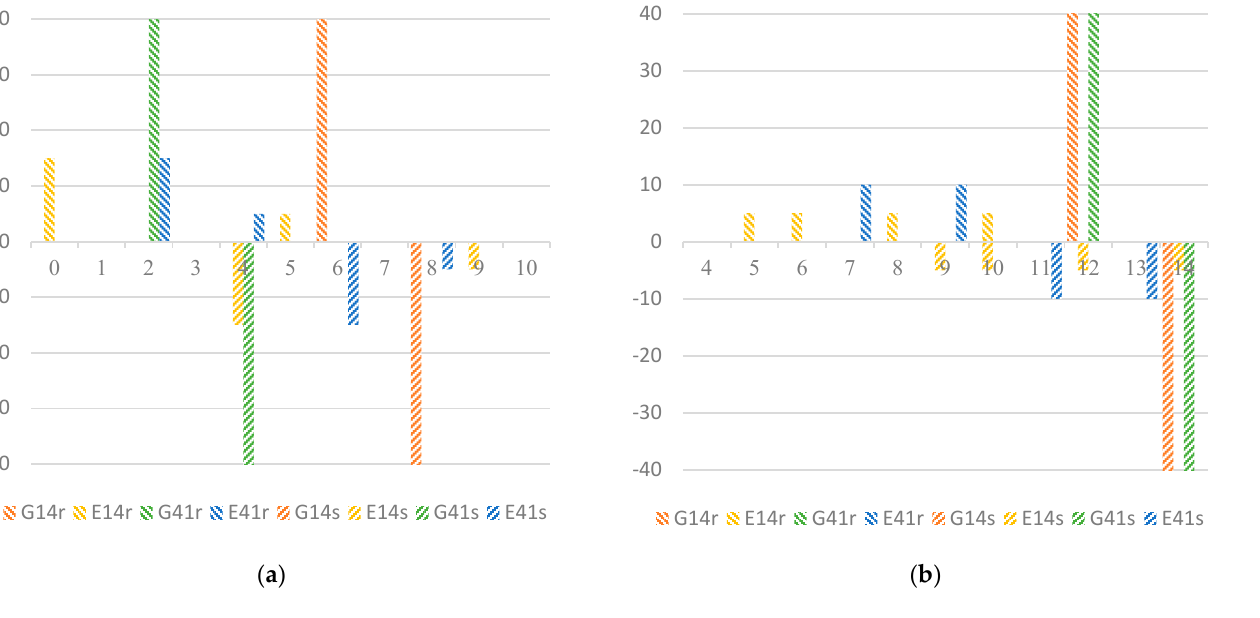
Figure 9. ( a ) Instantaneous flow rate of task 1 for time period 0 to 10 under TN prior; ( b ) instantaneous flow rate of task 2 for time period 4 to 14 under TN prior. (G represents GV, E represents EV, 14 and 41 are O–D pairs, r represents departing flow, and s represents arriving flow). Figure 10 provides the path assignment. The blue bars represent the instantaneous departing flow assigned to paths passing through station 1 (cid:13) . The blue line represents the real power demand of station 1 (cid:13) . The orange bars represent the instantaneous departing flow assigned to paths passing through station ② . The orange line represents the real power demand of station ② . All EVs are assigned to path 1 ① 24 and 42 ① 1. All EVs pass through station ① .